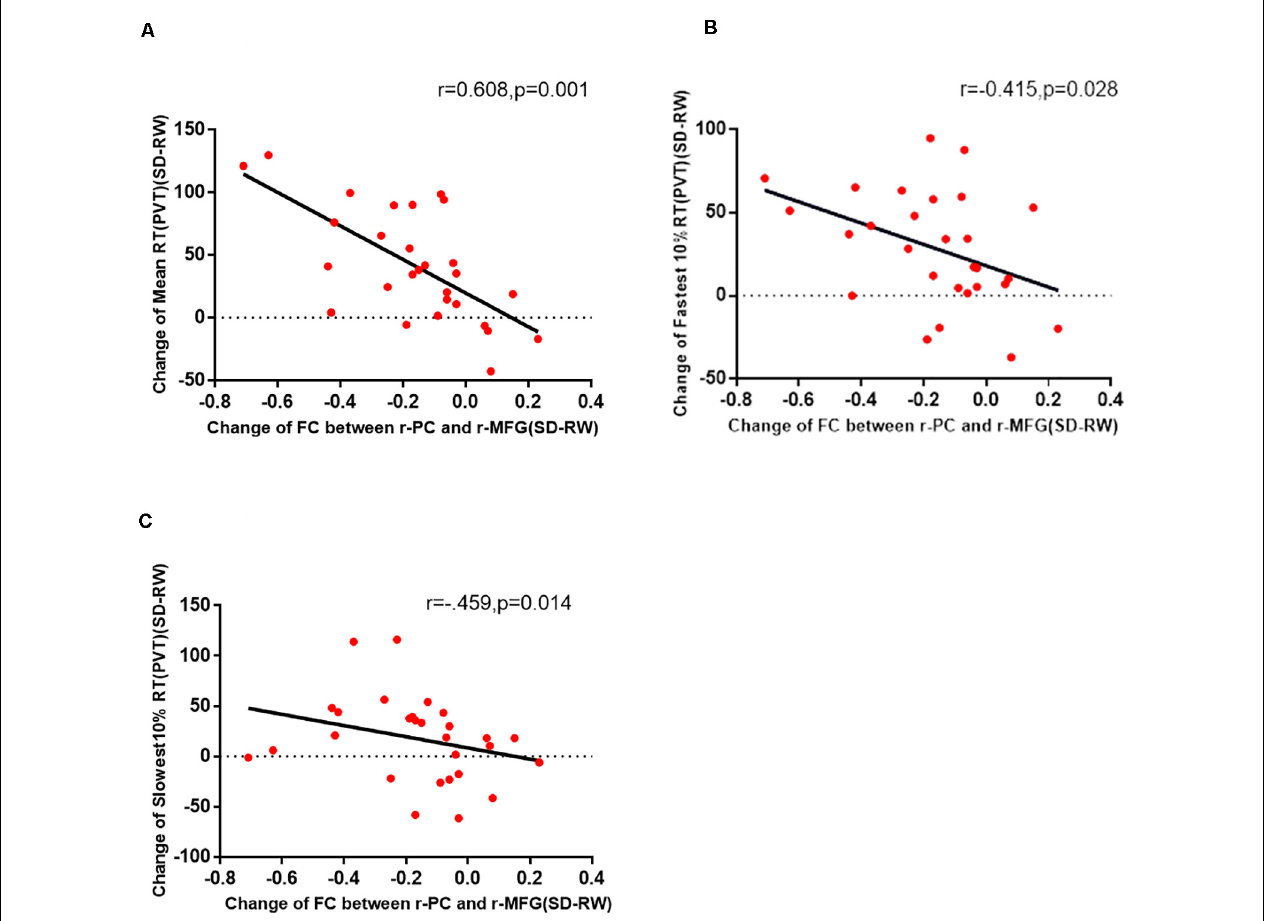
FIGURE 4 | The change in functional connectivity between the right PC and the right MFG was significantly correlated with the mean RT (A) , fastest 10% RT (B) , and slowest 10% RT (C) of PVT. PC, precuneus; MFG, right middle frontal gyrus; PVT, psychomotor vigilance test; SD, sleep deprivation; RW, rested wakefulness; RT, response